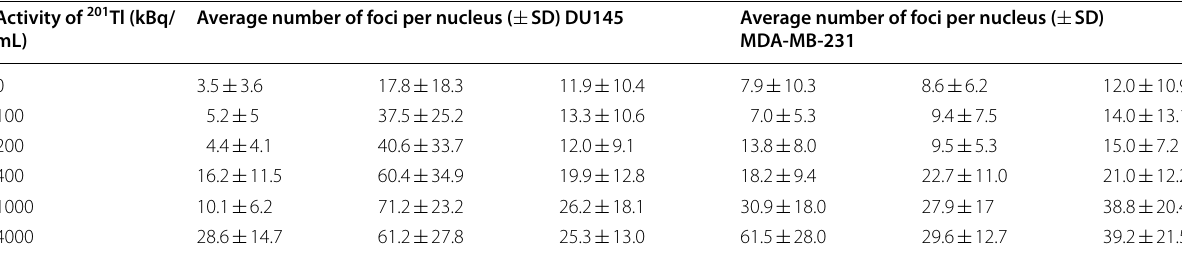
Average number of foci per nucleus in DU145 cells and MDA-MD-231 cells after 90 min incubation with various activities of [ 201 Tl]TlCl in medium , and with 0.9% NaCl (0 kBq/mL) measured in three independent experiments